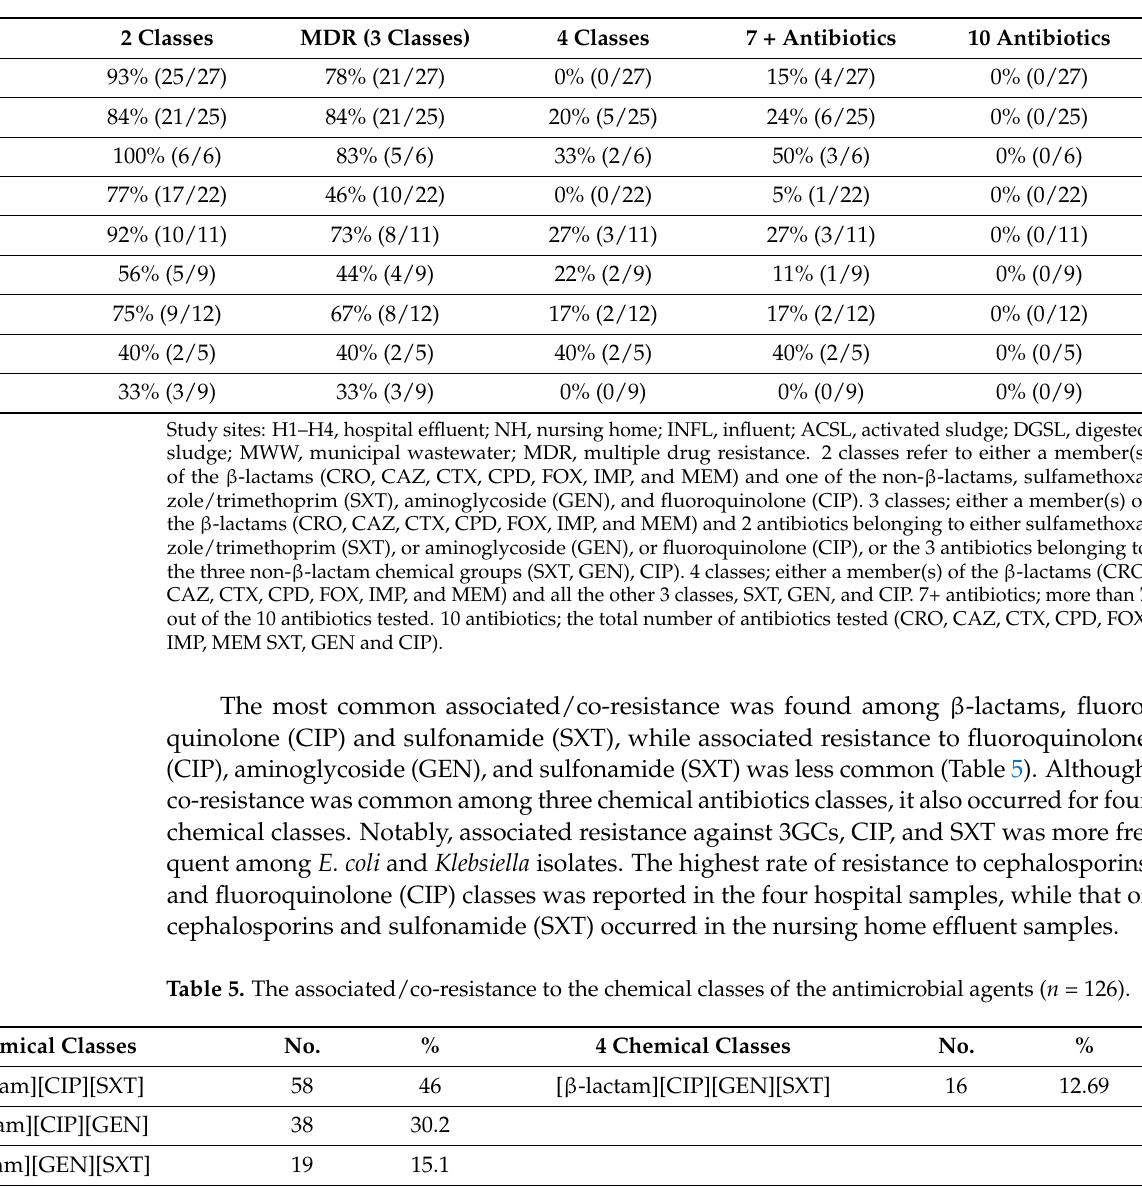
Table 4. The number of chemical classes and antibiotics to which the isolates showed resistance among the 10 antibiotics.